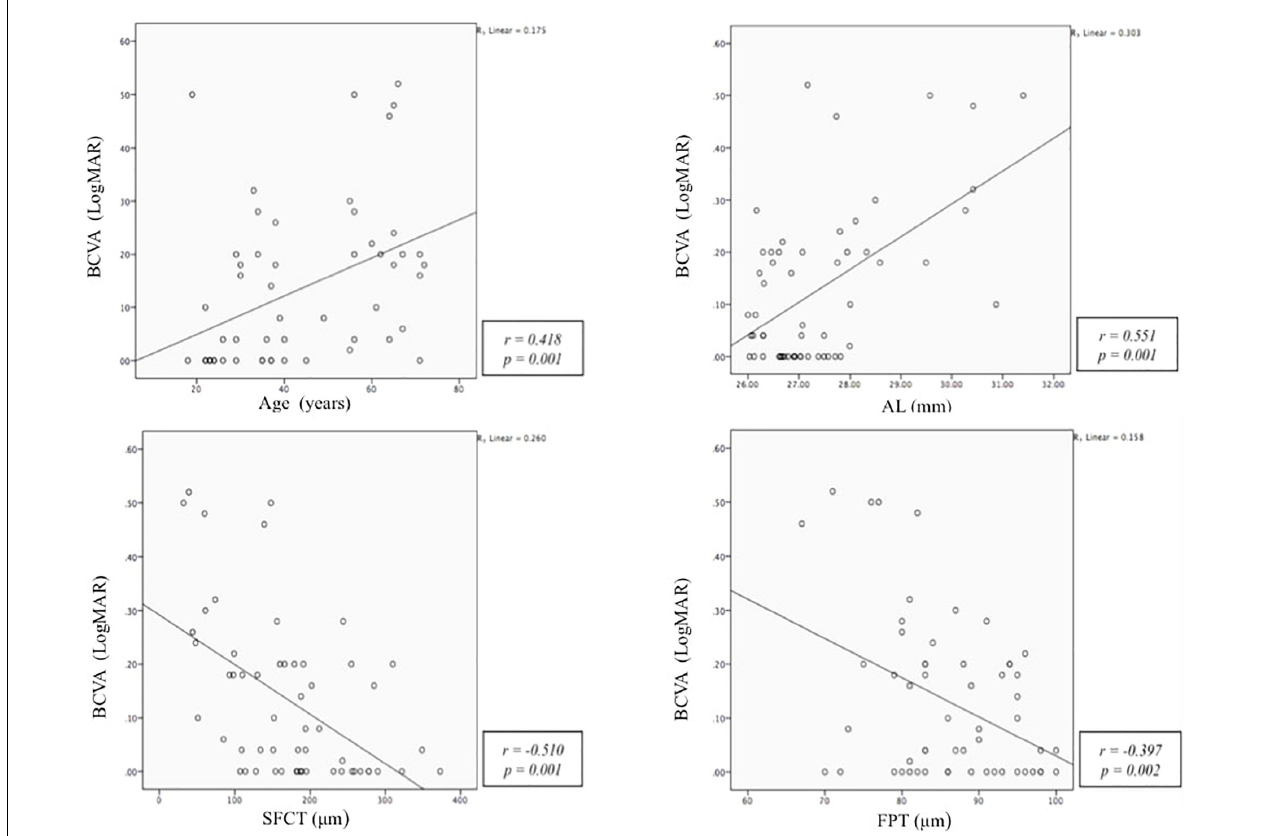
FIGURE 3 | Scatter plots of the best-corrected visual acuity (BCVA, LogMAR) with age (years), axial length (AXL, mm), subfoveal choroidal thickness (SFCT, µ m), and foveal photoreceptor thickness (FPT, µ m).